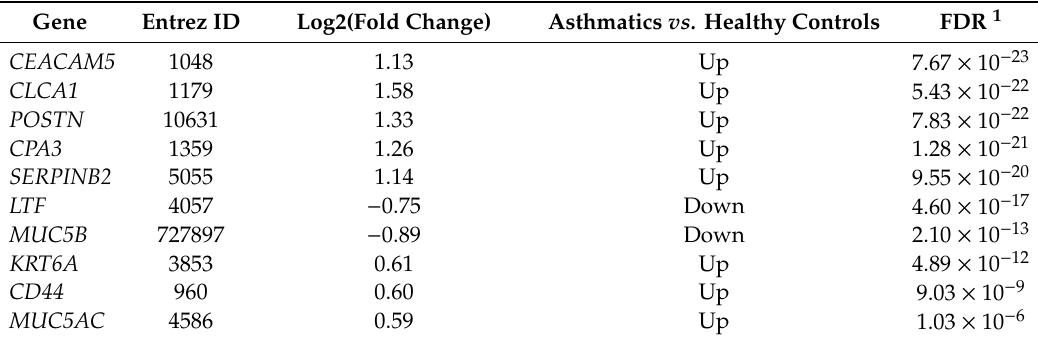
Table 2. The significant DEGs with fold change > 1.5 between asthmatics and healthy controls